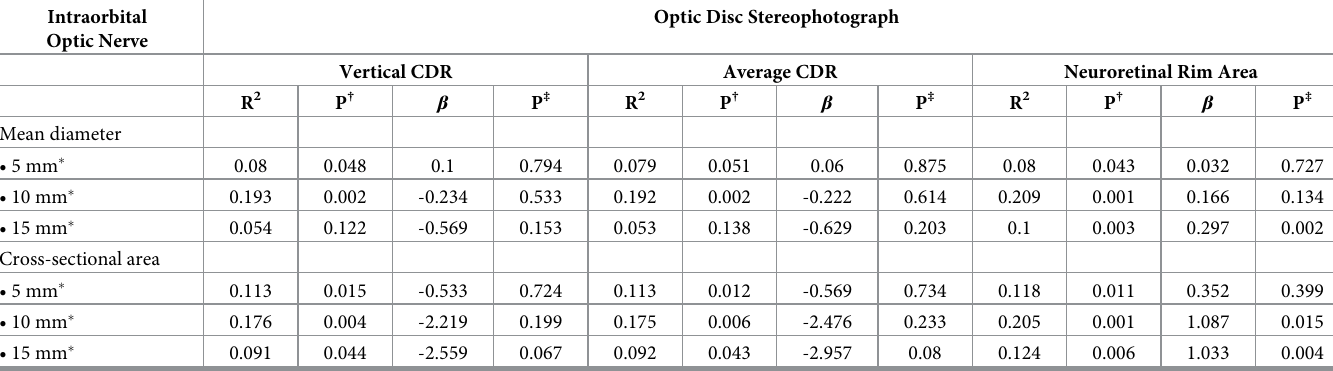
Table 4. Relationship between 3-Tesla magnetic resonance imaging findings of the intraorbital optic nerve and optic disc stereophotograph outcomes. Intraorbital Optic